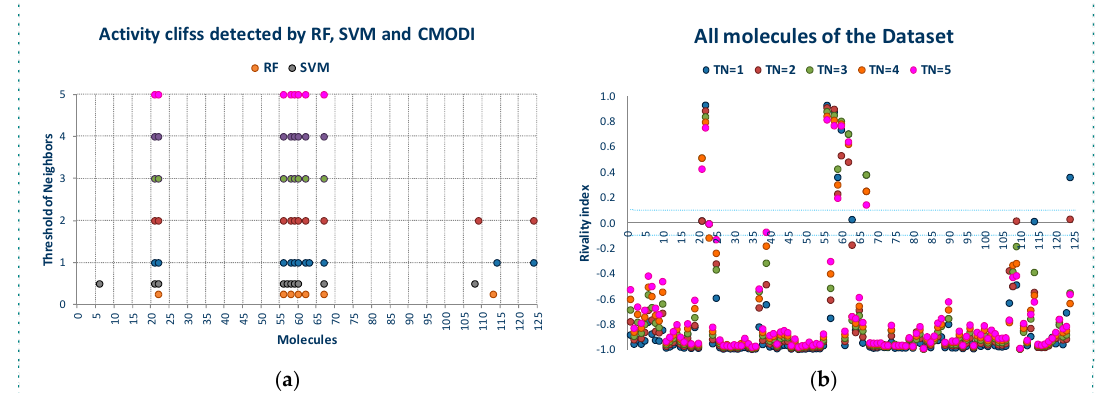
Figure 2. For YES1 dataset, outliers detected by the modelability index for different values of TN ( a ), values of the rivality index for different values of TN ( b ).